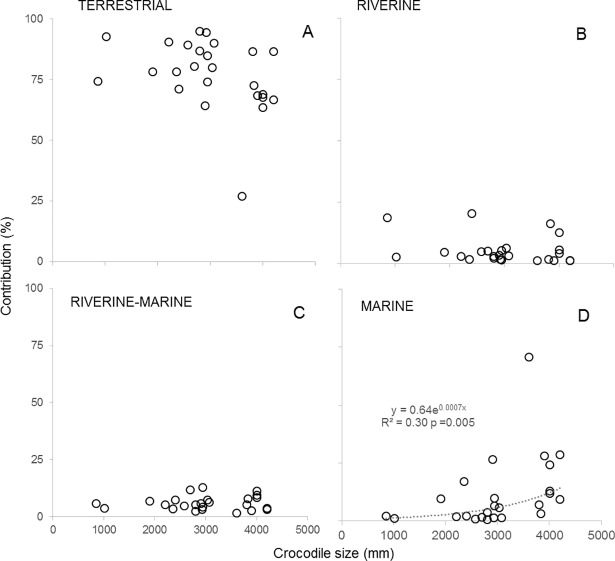
Contribution of (A) terrestrial, (B) riverine, (C) riverine-marine and (D) marine prey to the diet of estuarine crocodiles. The contribution was assessed with SIAR solo using data from crocodiles ranging from 0.85 to 4.2 m long (TL).